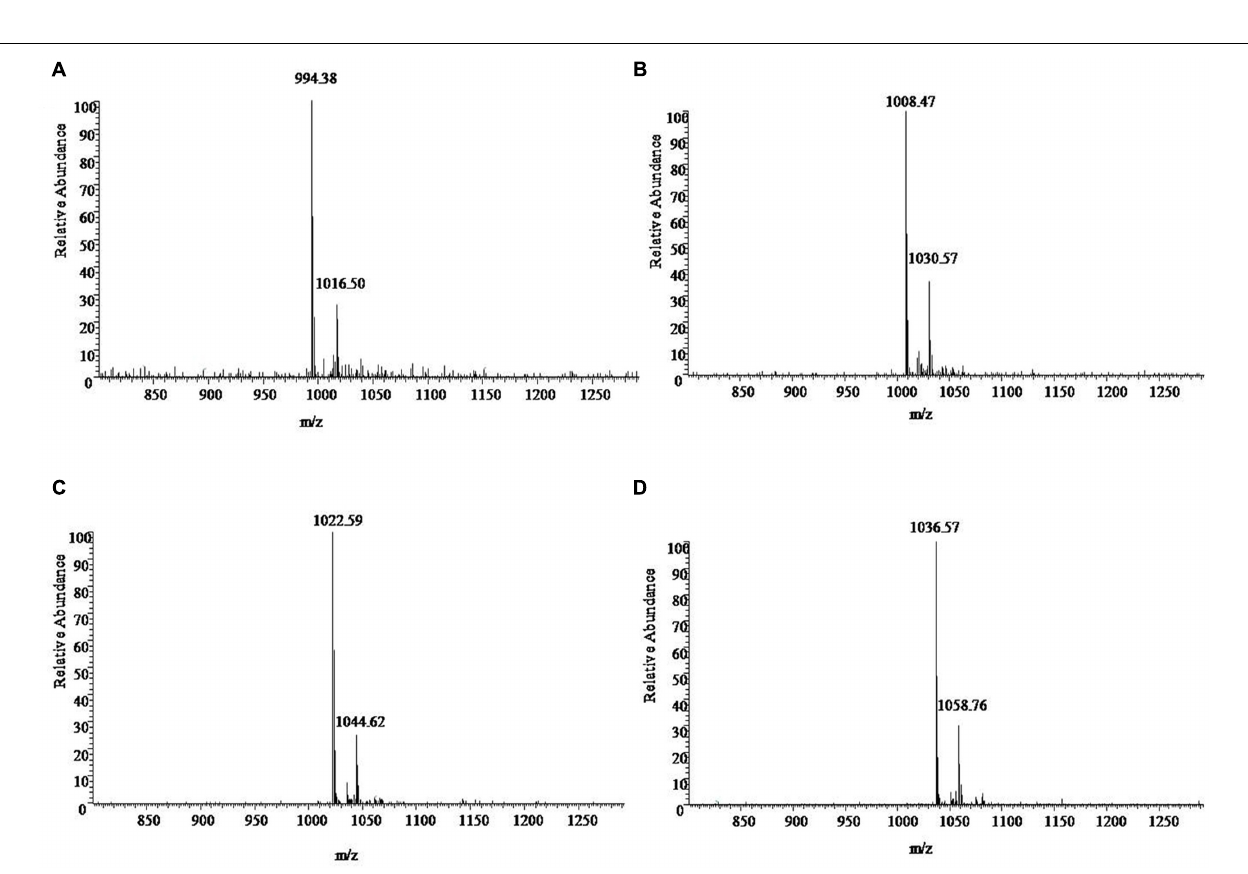
FIGURE 4 | The ESI-MS [M+H] + chromatogram of sample. (A) 994 is the characteristics of the molecular weight, with a surfactin precursor ion [M+Na] + at m/z 1016. (B) 1008 is the characteristics of the molecular weight, with a surfactin precursor ion [M+Na] + at m/z 1030. (C) 1022 is the characteristics of the molecular weight with a surfactin precursor ion [M+Na] + at m/z 1044. (D) 1036 is the characteristics of the molecular weight, with a surfactin precursor ion [M+Na] + at m/z 1058.